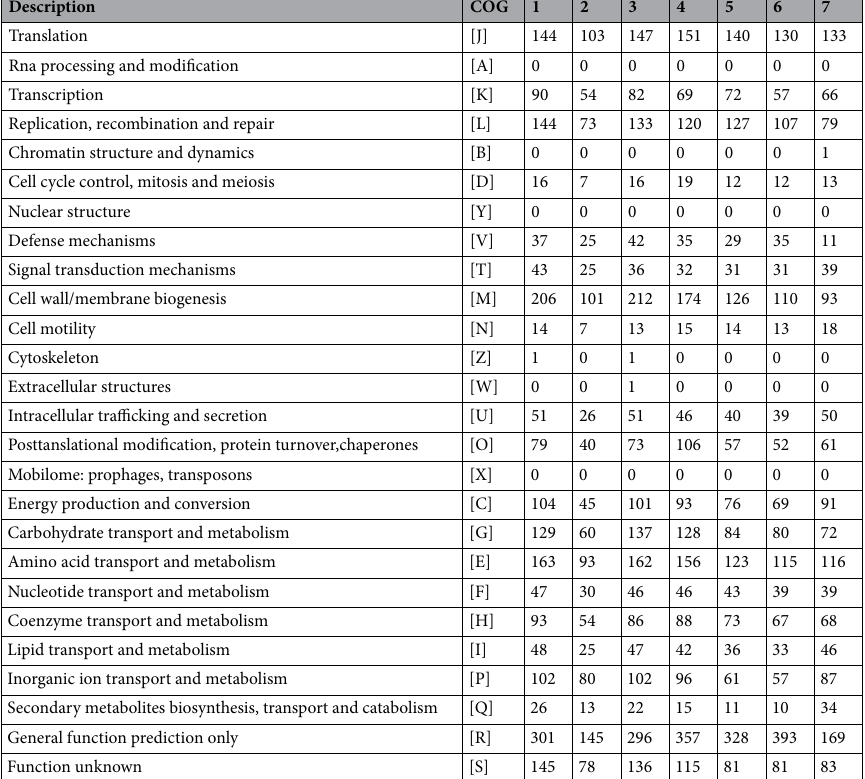
d-galactose, d-glucose, d-fructose, d-mannose, d-mannitol, d-sorbitol, mucin, N -acetylglucosamine, salicin, esculin ferric citrate, cellobiose, d-maltose, d-lactose, d-melibiose, amygdaline, d-saccharose, d-trehalose, arbutine, gentiobiose, d-turanose, d-tagalose and potassium gluconate. Strain Marseille-P6666 T does not uti- lize glycerol, erythritol, d-arabinose, d-xylose, l-xylose, d-adonitol, methyl-α d-mannopyranoside Methyl-α d-glucopyranoside, l-sorbose, l-rhamnose, dulcitol, inositol, Methyl-α d-Glucopyranoside, Methyl-α d-Man- nopyranoside, inulin, d-melezitose, d-raffinose, glycogen, amidon, d-fucose, l-fucose, d-arabitol, l-arabitol, potassium 2-cetogluconate and potassium 5-cetogluconate. The major fatty acids are 12-methyl-tetradecanoic acid, pentadecanoic acid. Acetic acid and propanoic acid are produced. Various polar lipids classes are found: sphingomyelins, N -acyl ethanolamines, acyl carnitine, phosphatidylethanolamine, lysophosphatidyléthanola- mine, phosphatidylcholine, lysophosphatidylcholine, ceramides—glycero lipids, fatty acyls—glycero lipids, phos- phatidic acid and several unknown structures and phospholipids. The DNA G + C content of the genomic DNA is 57.8%. The type strain Marseille-P6666 T (= CSUR P6666 = CECT 30548), was isolated from human stool.